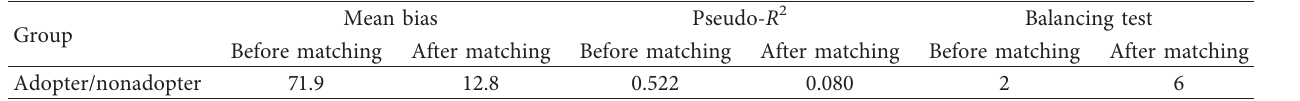
Table 10: Distribution of matching quality